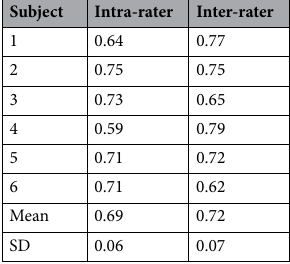
Table 4. Dice similarity coefficient (DSC) results of the intra-rater and inter-rater image segmentation quality assessments in 6 healthy